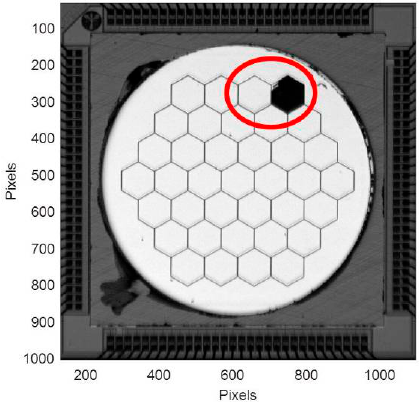
Figure 6. PTT111 device tested in our experiment (engineering grade device). Segments #23 and #24 (in the red circle) are lockouts. (in the red circle) are